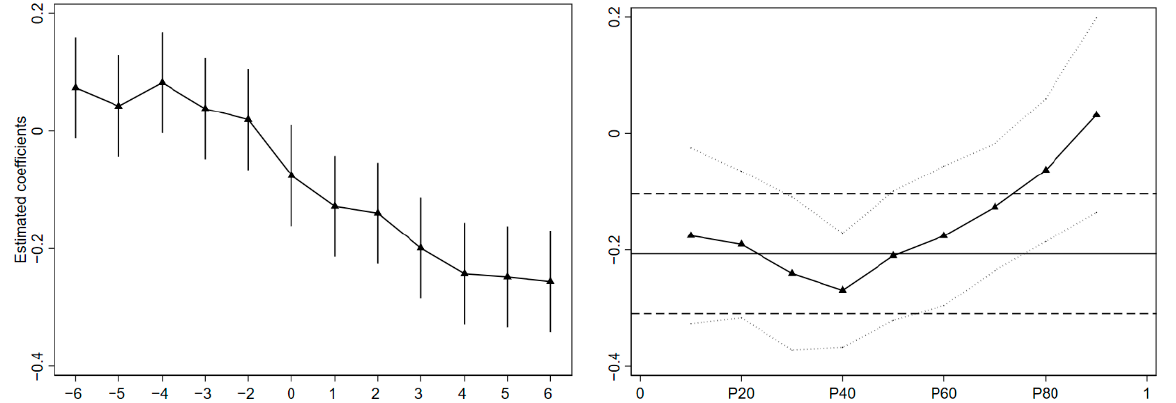
Figure 4. Parallel trend test and CIC test. Note: The picture on the left is the parallel trend test. In the figure, the abscissa “ − 2” represents the 2nd year before the implementation of the policy, and “2” represents the 2nd year after the implementation of the policy. The ordinate represents the estimated coefficients. The picture on the right is the CIC test. The article uses data from six years before and after policy implementation for analysis. The abscissa represents the quantiles. The vertical axis represents the estimated value of the treatment effect. Solid lines with small triangles represent estimated coefficients at different quantiles. The solid horizontal line is the mean CIC estimate. The horizontal dashed line is its 95% confidence interval. Table 4. Heterogeneity